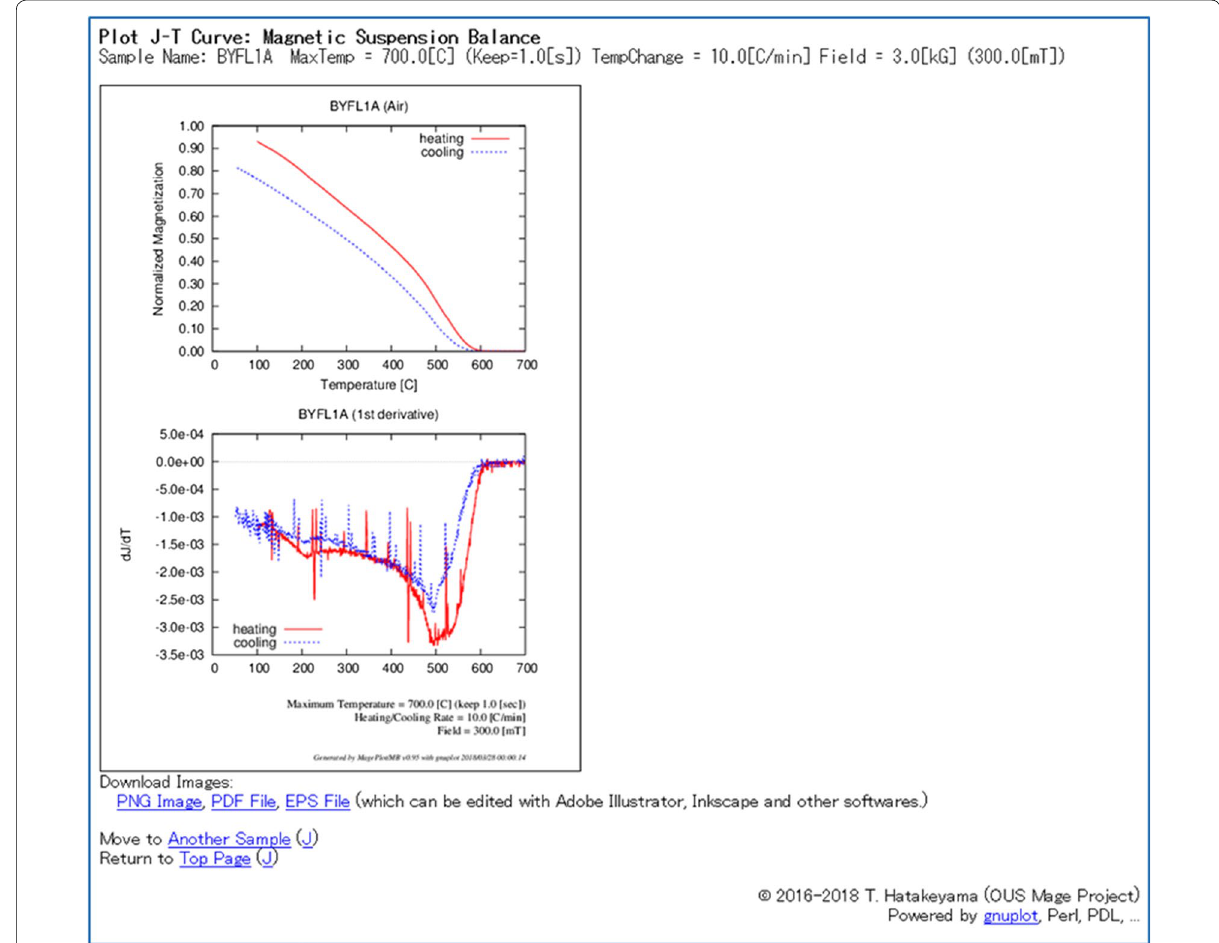
Fig. 4 Screenshot of the results window of the MagePlot/MB service. Here, the option for normalization was selected, and the cutoff temperature in the heating process is given at 100 °C. The lower plot shows the first-derivative